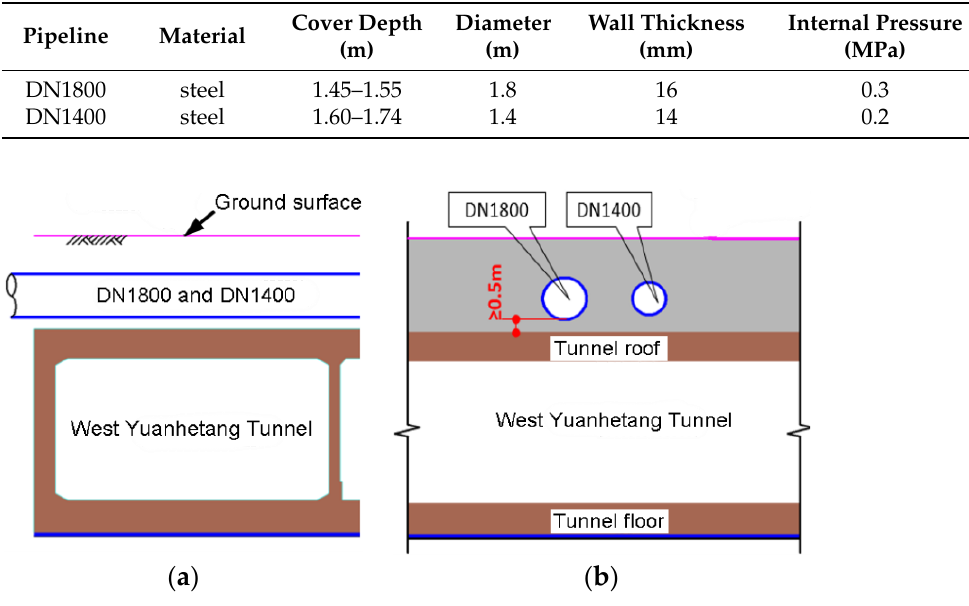
Figure 1. Schematic diagram of the relative position between pipelines and tunnel: ( a ) Transverse section; ( b ) Longitudinal section.